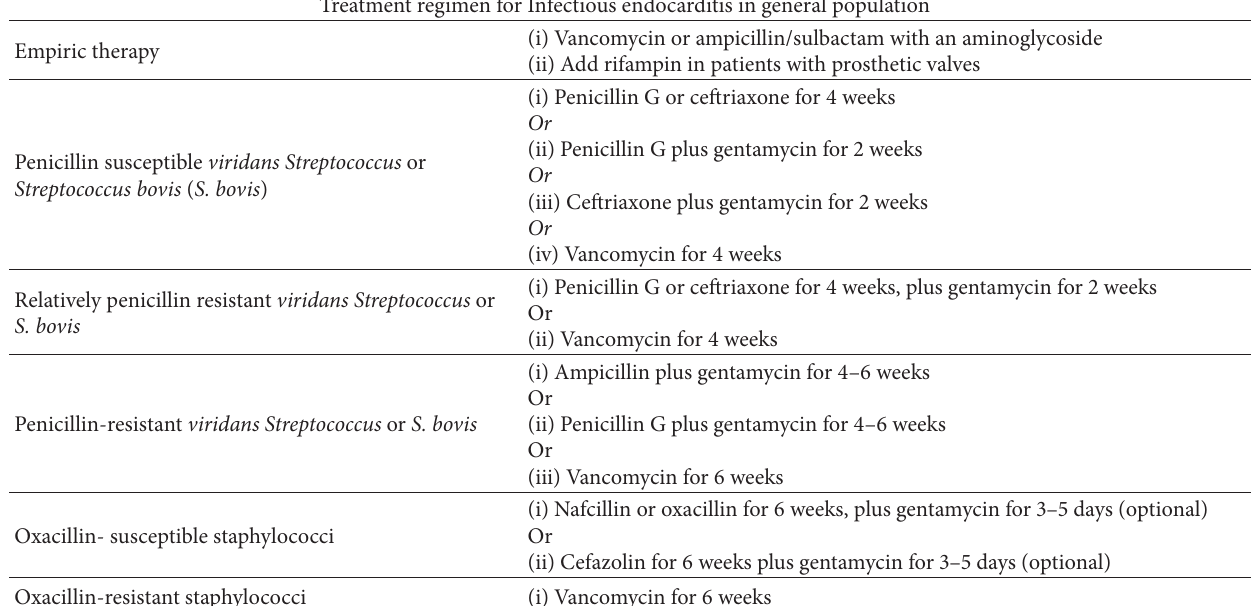
Table 2: Depicting the suggested treatment regime for infective endocarditis in the general population as per guidelines published in American Family Physician.